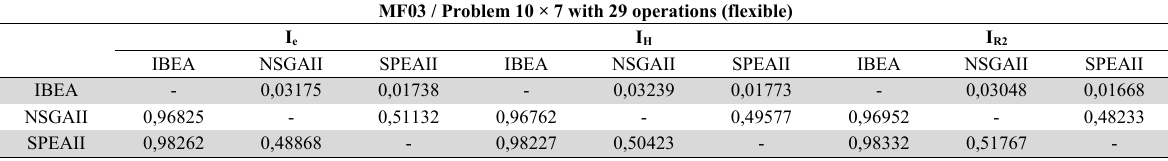
I e , I H , and I R2 (MF03) for IBEA, NSGAII and SPEAII MF03 / Problem 10 × 7 with 29 operations